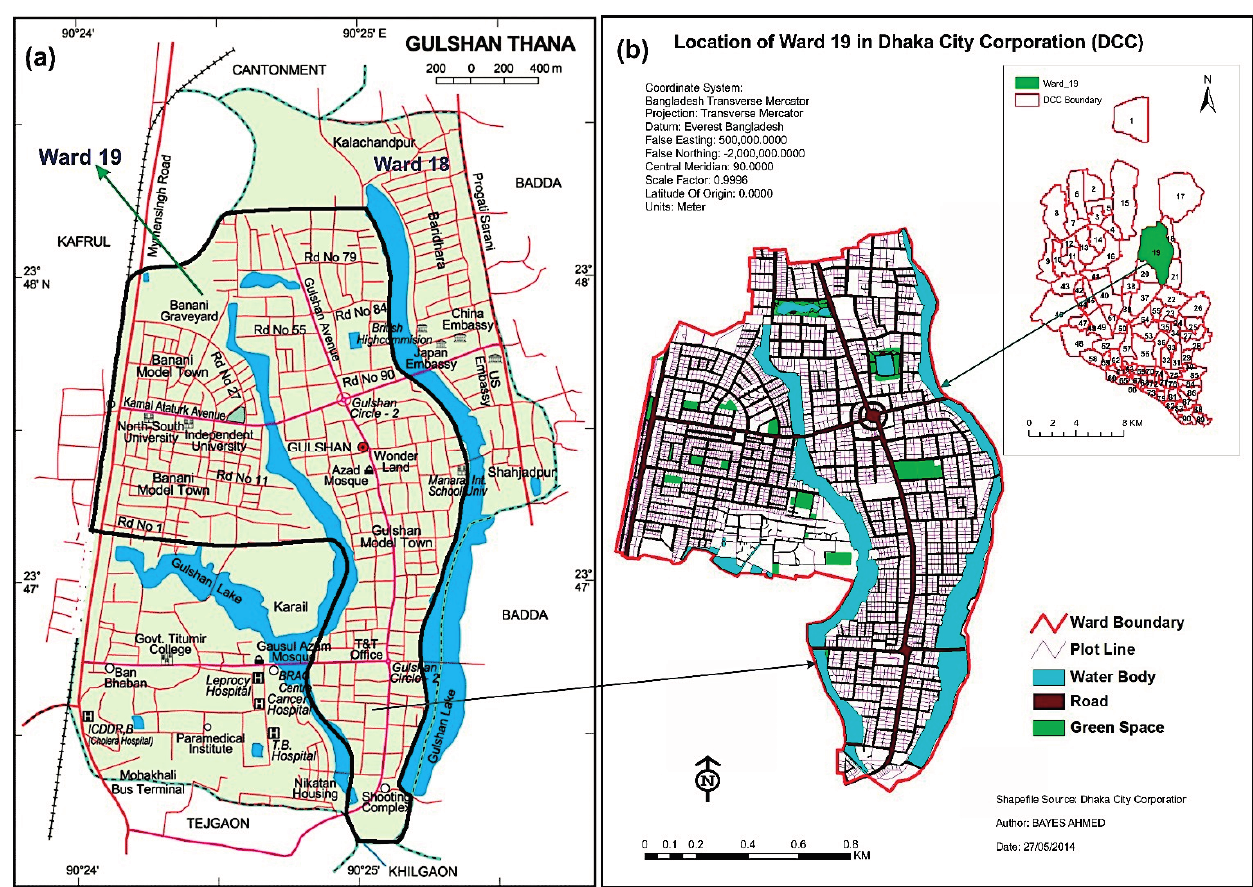
Figure 4. Location of ward 19 ( a ) in Gulshan thana and ( b ) in DCC. Source: (a) Banglapedia , National Encyclopedia of Bangladesh,